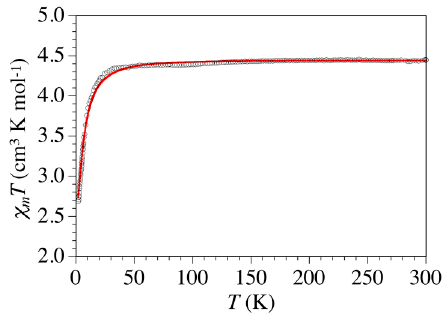
Figure 4. Thermal variation of the χ m T product per Fe(III) ion for compound 1 . Solid line is the best fit to the model (see text).